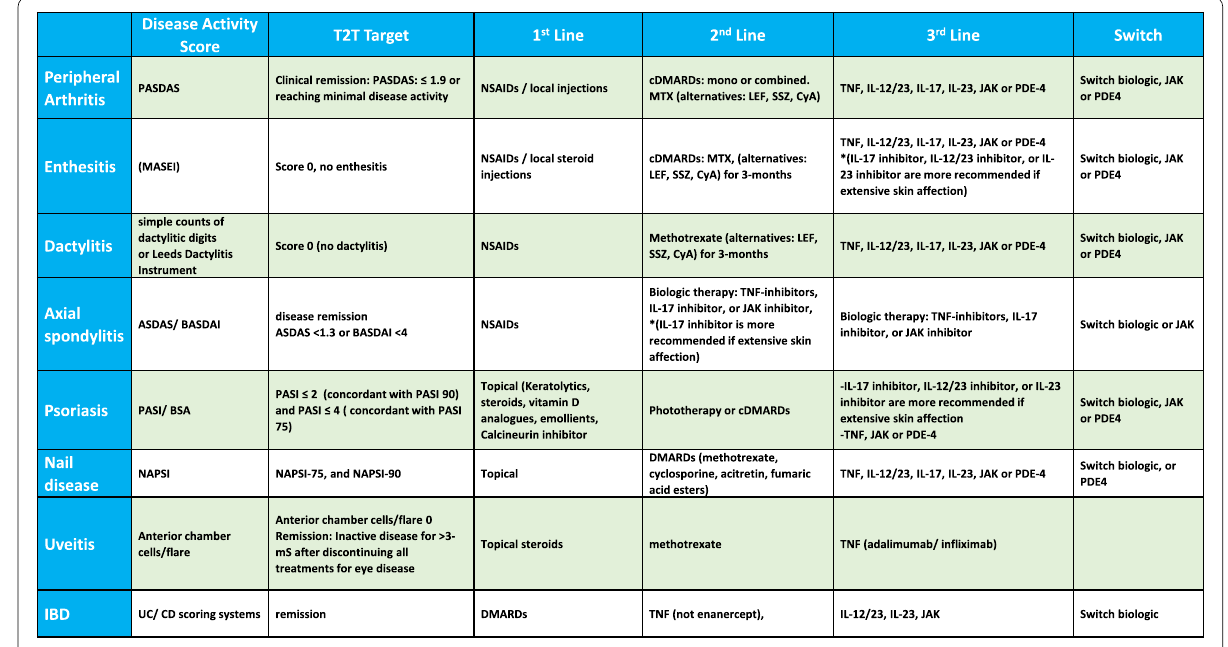
Fig. 2 algorithm for personalized management approach presenting with PSA patients and/or one of its clinical